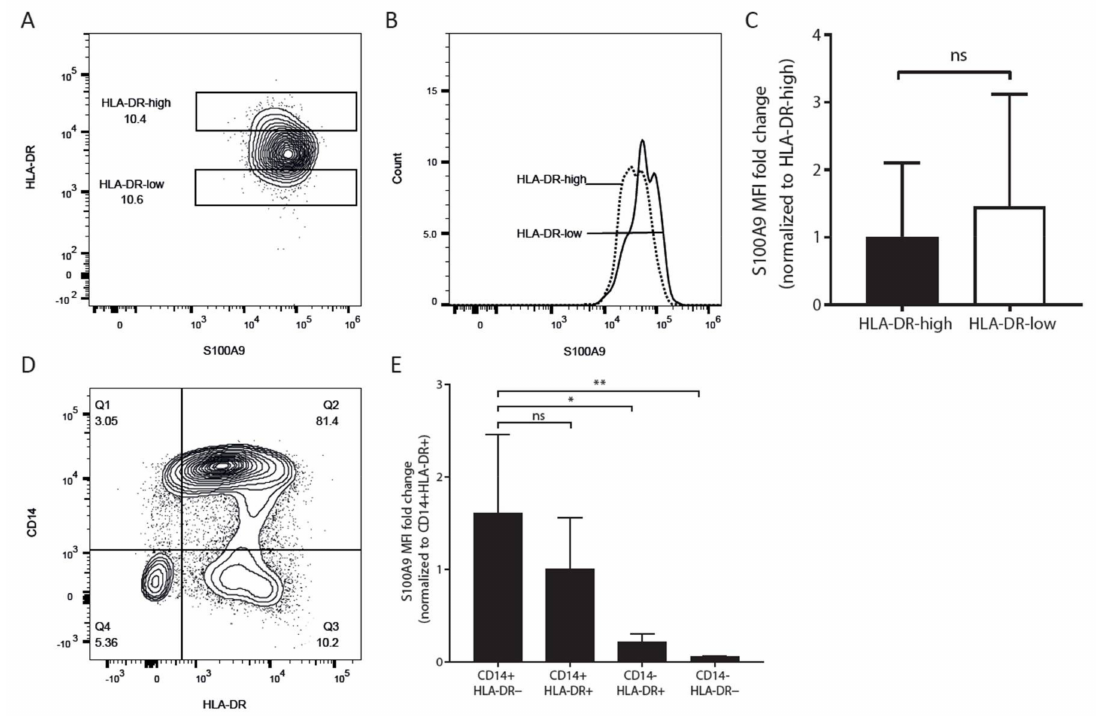
Figure 2. S100A9-positive monocytes express HLA-DR. Peripheral blood mononuclear cells (PBMC) were stained for CD14, HLA-DR, and S100A9, and were gated on CD14+ cell populations. ( A ) Representative FACS plot showing that CD14+ monocytes express both HLA-DR and S100A9. Gates were set to the upper and lower 10% of HLA-DR expression for the CD14+ monocytes, to further study subsets; ( B , C ) S100A9 expression was not significant between HLA-DR-high and HLA-DR-low subsets, although, S100A9 was slightly higher in the latter subset. Significant differences were calculated by t -test; ( D ) Representative FACS plot showing expression of CD14 and HLA-DR in gated CD33+ myeloid cells; ( E ) Monocytic MDSC (CD14+ HLA-DR − ) subsets showed slightly higher expression of S100A9 than CD14+ HLA-DR+ subsets, but this was not significant. The differences were tested by one-way ANOVA with Tukey’s multiple comparison tests. All data are expressed as means ± SD of four different experiments. * p < 0.05, ** p <